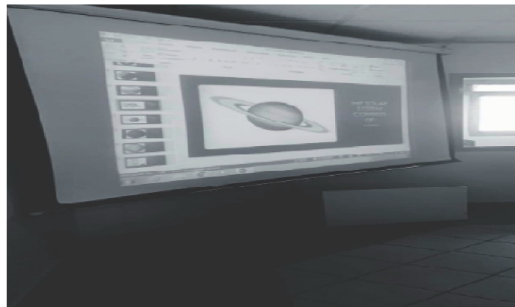
Figure 2: Learning by using multimedia presentations (control group).